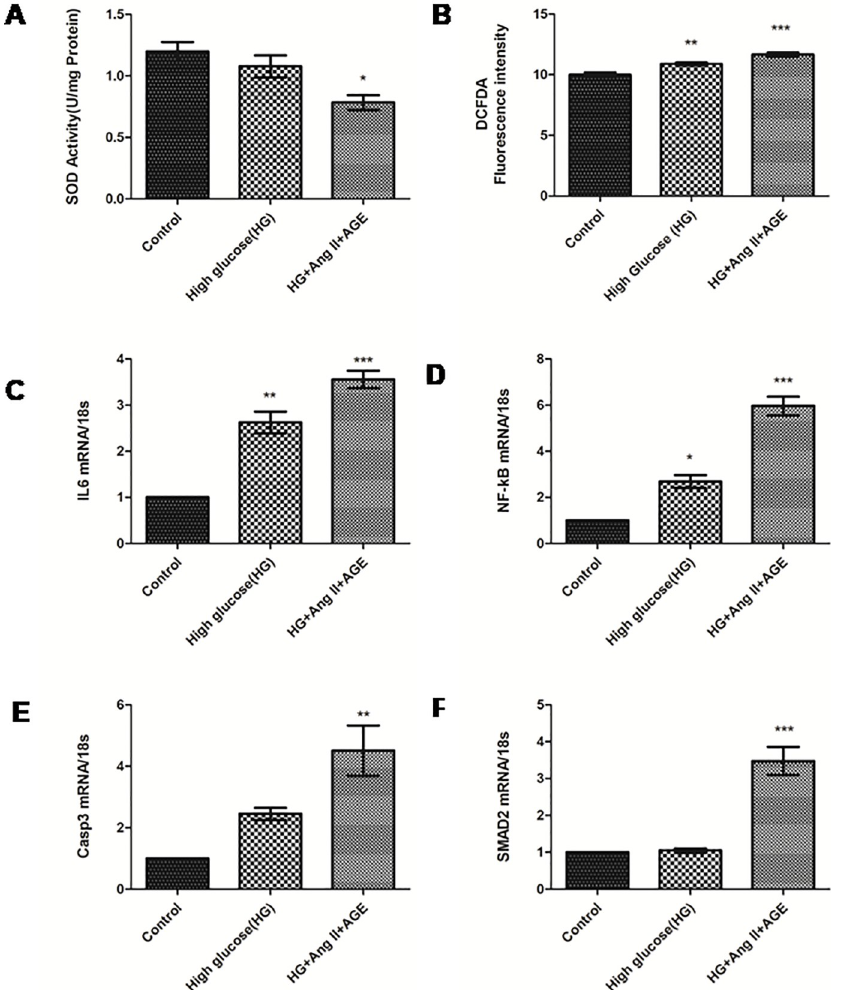
Fig 3. Measurement of oxidative stress and expression profile of their markers. A and B : Measurement of SOD activity and intracellular ROS production by DCFDA dye in control, HG and cells treated with HG, Ang II and AGE product respectively C, D, E, F: Assessment of mRNA level of IL6, NF- κβ , Caspase3 and SMAD2 in control, high glucose and cells treated with HG, Ang II and AGE product respectively. Results are represented as mean ± S.D. (n = 3) , � p < 0.05, �� p < 0.01, ��� p < 0.001 which shows significant data when compared with control